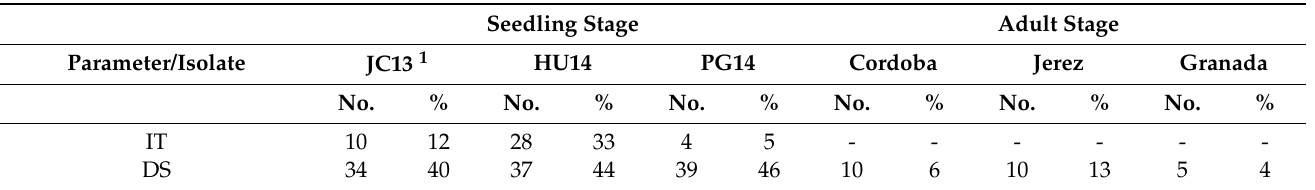
Table 1. Number of resistant landraces (IT < 7 or DS ≤ 10) to specific isolates of leaf rust at the seedling stage and at the adult stage in field experiments at three locations. Adult